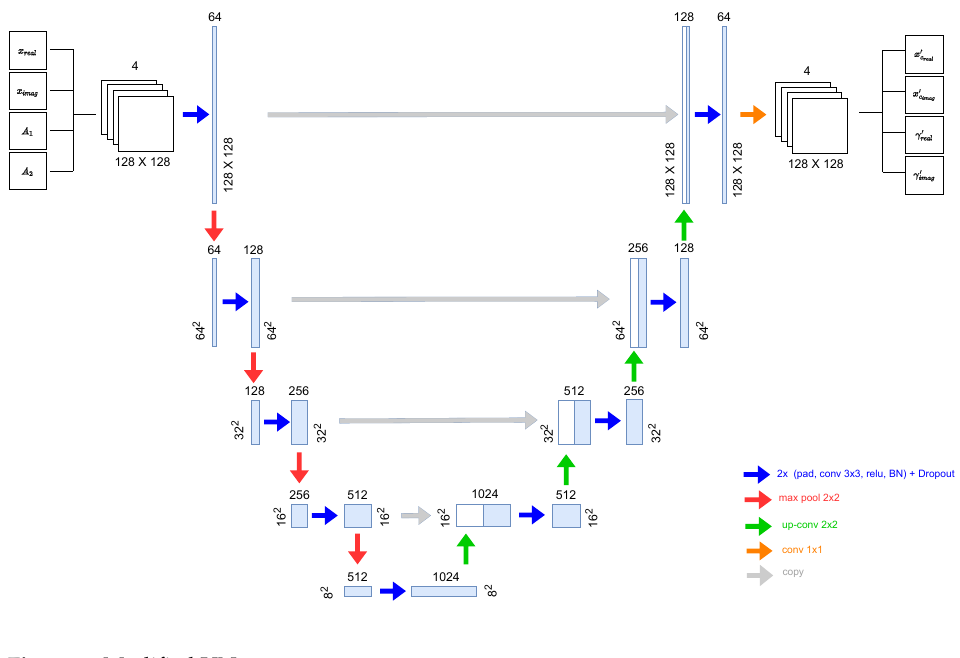
Figure 5. Modified